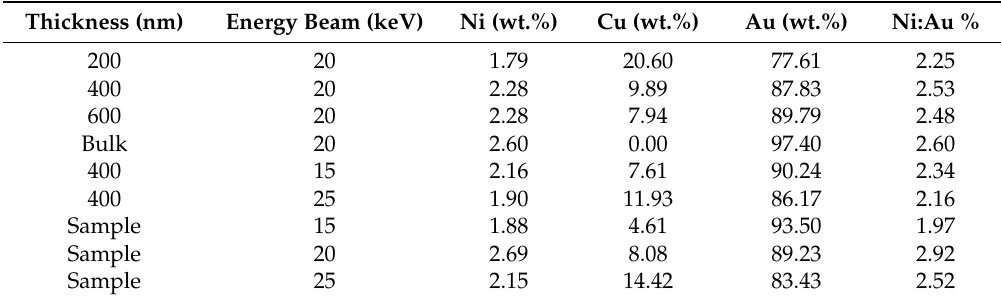
Table 3. Ni:Au fractions in simulation and measurements of gold–nickel alloy on copper varying thickness and